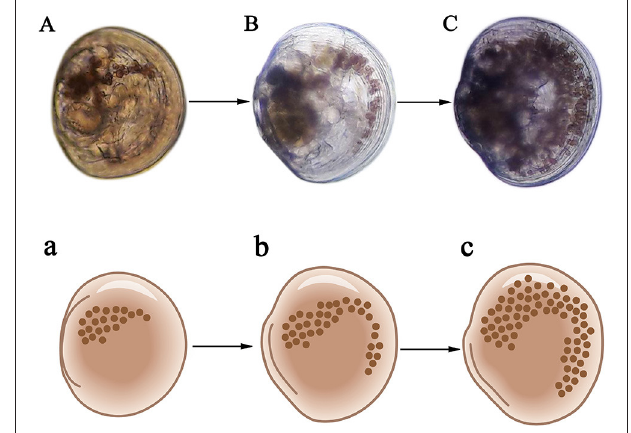
FIGURE 3 | Newly-formed spat with gills, feet, secondary shells, and zooxanthellal tubular systems. (A) Spat with over 30 zooxanthellae; (B) Spat with over 100 zooxanthellae; (C) Spat with over 300 zooxanthellae. a–c are schematic diagrams corresponding to (A–C)